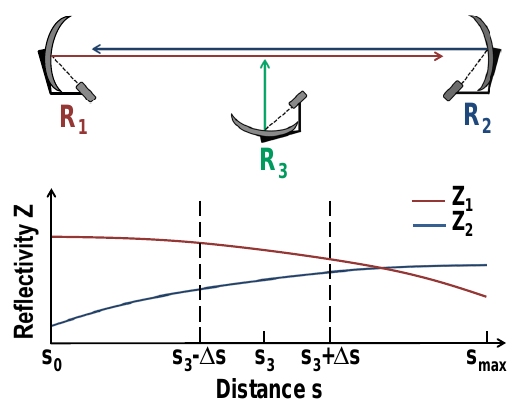
Figure 1. Schematic network setup including horizontally oriented radars R 1 and R 2 and vertically oriented radar R 3 (top panel) and schematic reflectivity measurements for R 1 and R 2 along the con- necting line (bottom